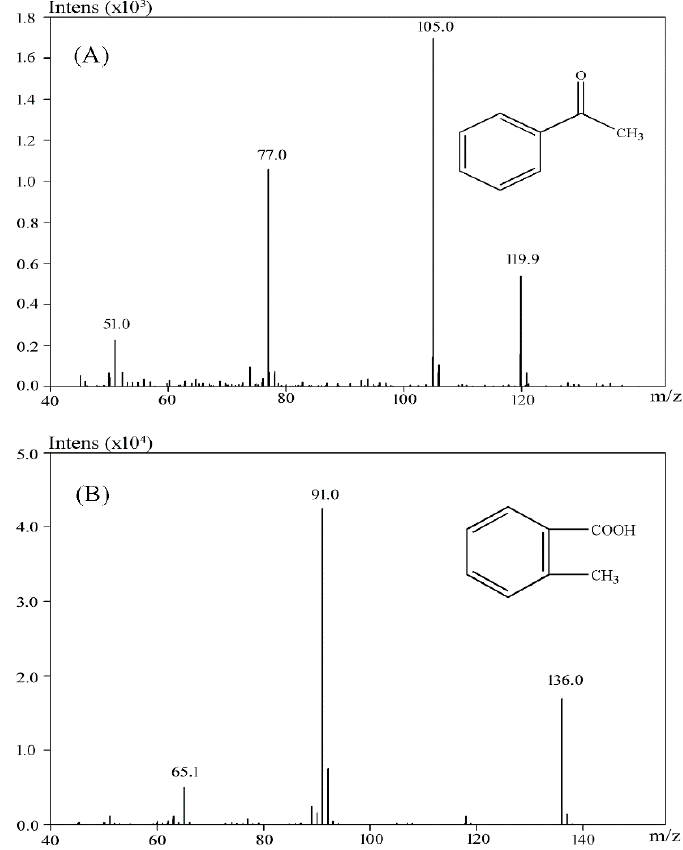
Figure 7. Identification of metabolites of Reactive Blue 19 by GC-MS analysis. ( A ) acetophenone (retention time 10.98 min); ( B ) 2-methylbenzoic acid (retention time 16.21